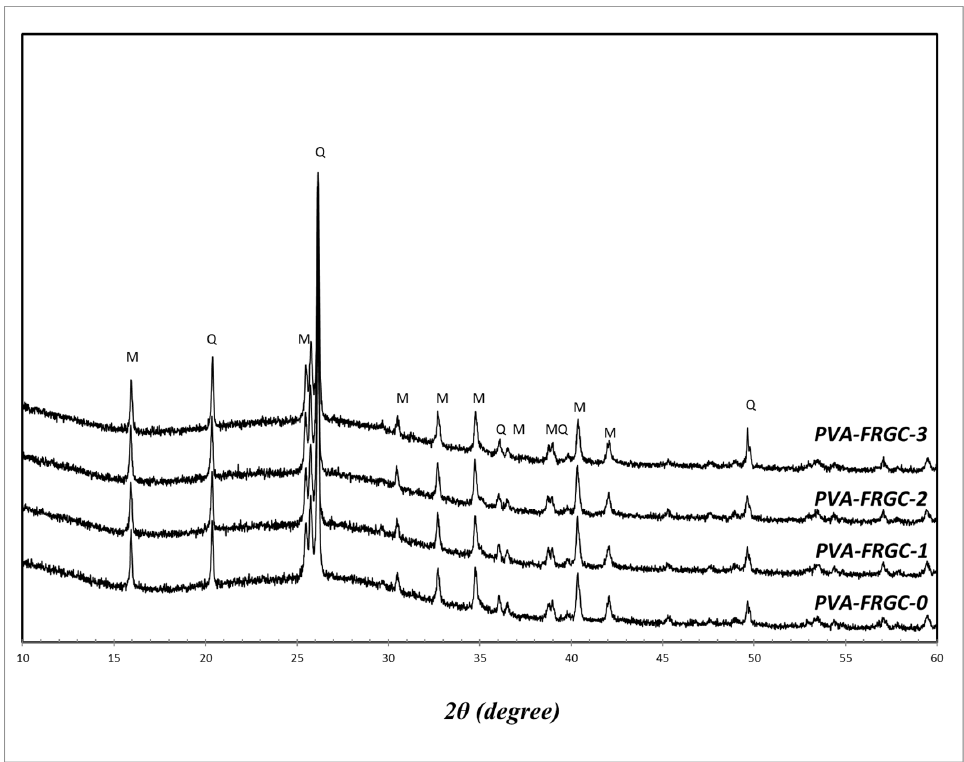
Figure 7. XRD patterns of geopolymer composites.